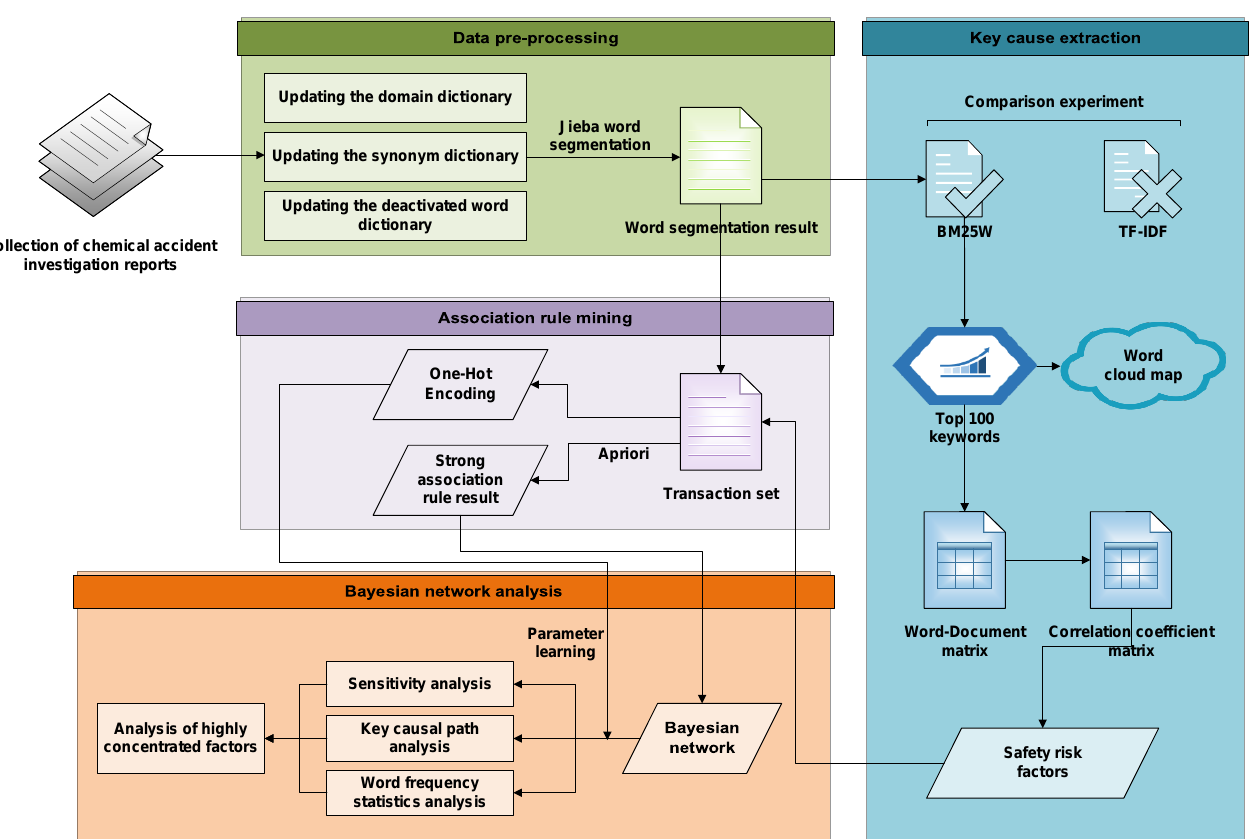
Figure 2. The framework of research on safety risk factors of chemical accidents.